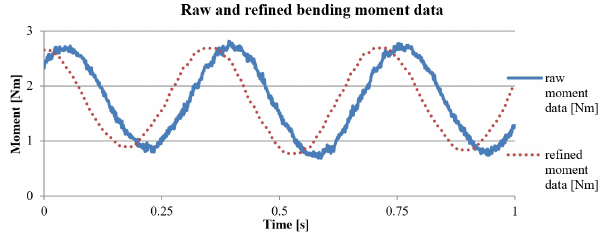
Figure 3. Sample of raw and refined bending data values from con- figuration A.